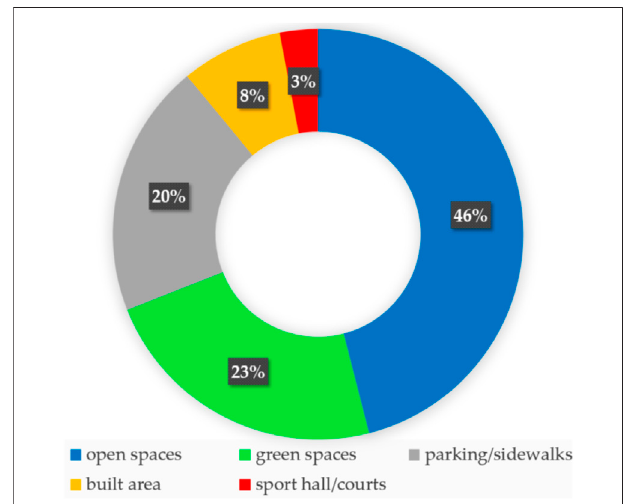
FIGURE 1 | GJU main campus total area